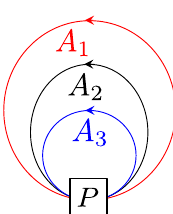
Figure 7. The generalized higher-rank Wilson loop: it is defined by joining together multiple fundamental Wilson loops with different areas by a projector P to a particular